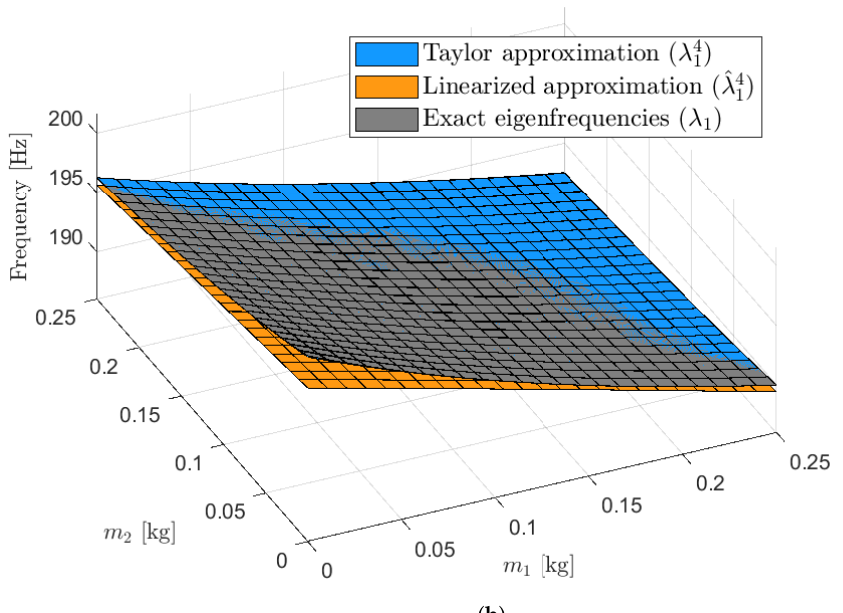
Figure 3. Comparison of approximated and exact eigenfrequency versus ( a ) generalized coordinates q and ( b ) design variables y